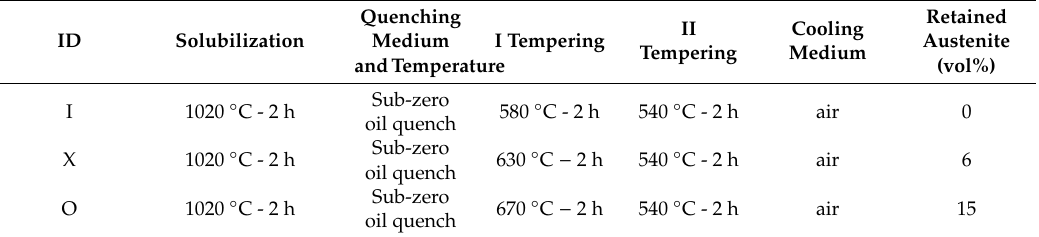
Table 2. Thermal treatment conditions for the steels under